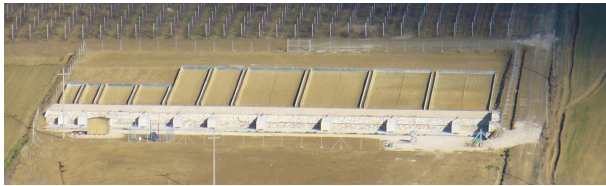
Figure 1. View of the Masse experimental station for monitoring water soil loss at plot scale in Umbria (central